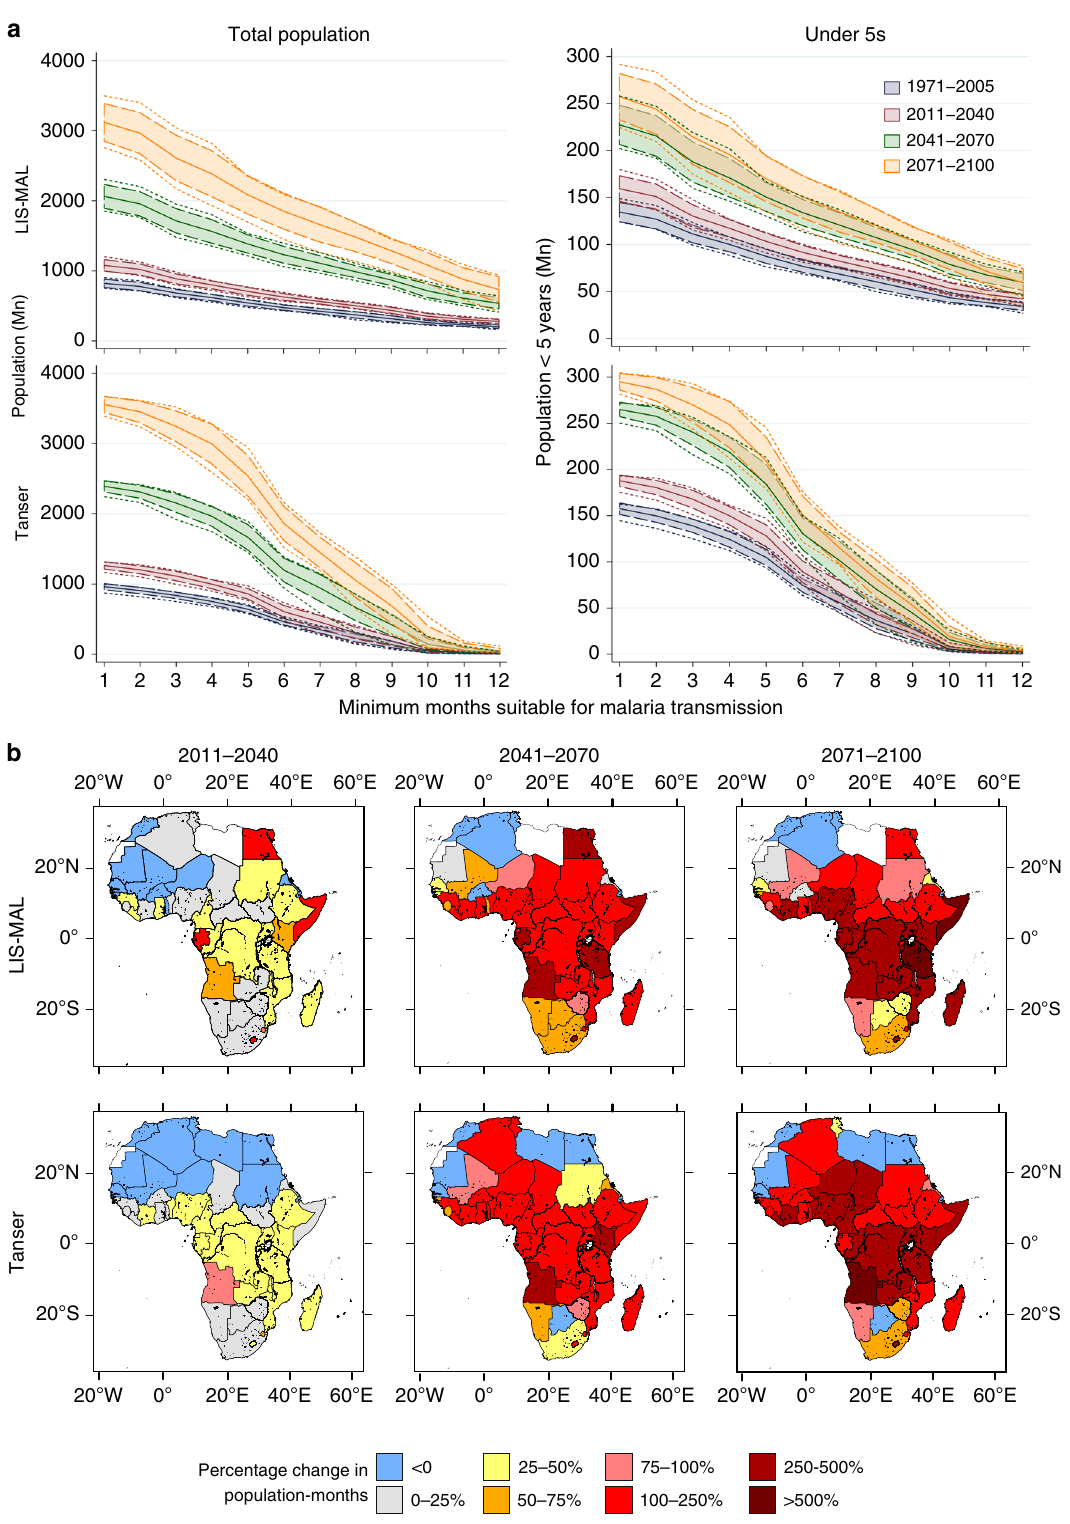
Fig. 4 Future populations in areas climatically suitable for malaria transmission. a Populations within areas climatically suitable for malaria transmission. Solid lines show the mean of the GCM forcing models, shaded areas indicate ±1 standard deviation and dashed lines show a range of predictions. Total population and under-5s calculated for both the Tanser rainfall threshold and LIS-MAL estimates using the WorldPop gridded distributions and UN medium variant projections for each period. b Predicted percentage changes in population-months (i.e. population exposed multiplied by the number of additional months of exposure) by country. White shading indicates no estimated malaria